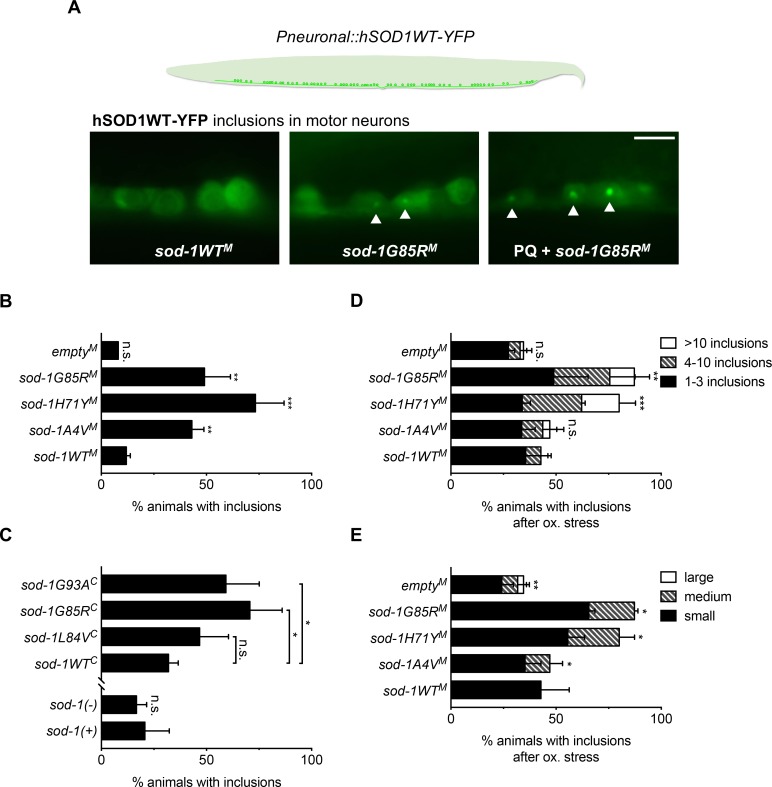
C. elegans single-copy/knock-in sod-1 alleles increase SOD1 inclusions in motor neurons.(A) Top: Cartoon illustration of the motor neurons examined to score hSOD1WT-YFP inclusion formation. Bottom: representative images of sod-1WTM and sod-1G85RM animals expressing hSOD1WT-YFP fusion protein [13] in ventral nerve cord motor neurons. sod-1G85RM animals had small neuronal inclusions that were largely absent in sod-1WTM wild type controls. Paraquat-induced oxidative stress (PQ or ox.) increased the number and size of the inclusions in sod-1G85RM animals. Inclusions in the middle image and right images were defined as small and medium size inclusions, respectively. Arrows point to inclusions. For oxidative stress trials, animals were treated with 2.5 mM paraquat for 3 hours. hSOD1WT-YFP was expressed under the pan-neuronal snb-1 promoter. Scale Bar = 10 um. (B) Single-copy ALS sod-1 mutations generated by MosSCI increased hSOD1WT-YFP inclusions compared to sod-1WTM controls. Three independent trials. All inclusions were small in size. N > 30 for every genotype in every panel. Chi-square test: * P < 0.05; ** P < 0.01; *** P < 0.001 in all panels. Unless otherwise indicated, comparisons were made to sod-1WTM animals. (C)
sod-1G85RC and sod-1G93AC knock-in ALS model animals generated by CRISPR/Cas9 had increased hSOD1WT-YFP inclusions compared to sod-1WTC wild type controls. Neither sod-1L84VC nor loss of sod-1 altered inclusions compared to sod-1WTC and sod-1(+) controls, respectively. sod-1(+) designates the unedited wild type gene at the endogenous locus; this is the same allele present in standard N2 strain. All inclusions were small in size.(D) Paraquat-induced oxidative stress increased inclusions in sod-1H71YM and sod-1G85RM model animals compared to sod-1WTM wild type controls. Inclusions were scored manually as small, medium or large. If their diameters were more than four times larger than the small inclusions shown in Panel 2A, they were counted as large. (E) Paraquat-induced oxidative stress increased the percentage of animals with medium-size inclusions in sod-1A4VM, sod-1H71YM and sod-1G85RM animals. Likewise, emptyM control animals had larger inclusions compared to sod-1WTM controls. Inclusions were scored manually as small, medium or large, as described above.